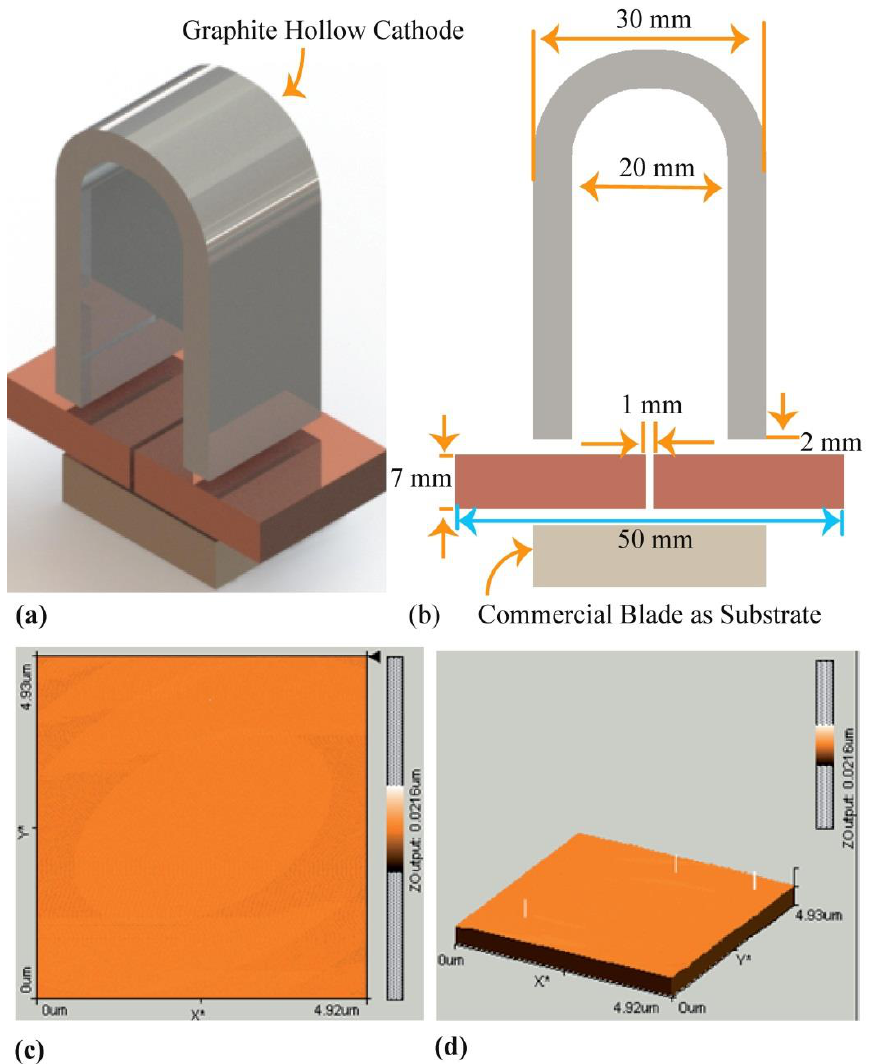
Figure 2. Schematic diagram of a hollow cathode ion source. ( a ) 3D render ( b ) 2D view, ( c ) AFM scan of the substrate, ( d ) 3D view. Scan area of 5 × 5 µ with a scan resolution of 30 nm.